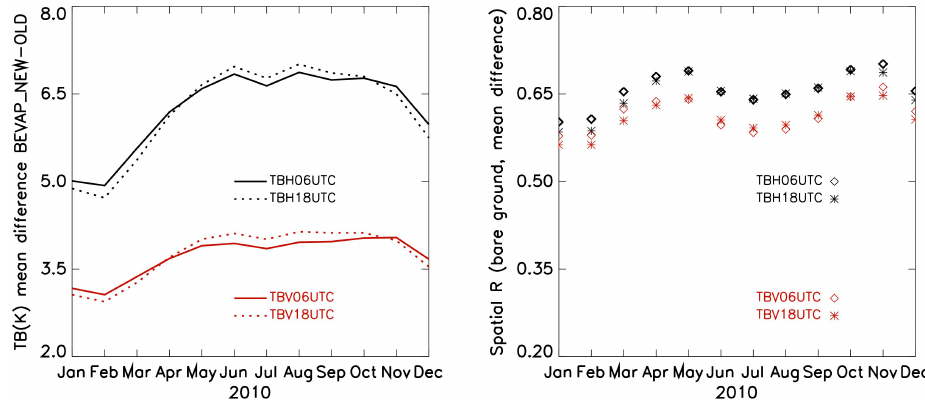
Fig. 7. (left) Brightness temperature global monthly mean sensitivity to the new bare soil parameterization for 2010 (solid and dashed lines), (right) spatial correlation between the fraction of bare ground and the brightness temperature global monthly difference (stars and diamonds). Both horizontal and vertical polarizations (40 ◦ incidence angle) are represented for 06:00UTC and 18:00UTC. Table 6. Monthly mean statistics of the difference between SMOS TB observations and simulated TB. Results are given at 06:00UTC, for both BEVAP OLD and BEVAP NEW, at both horizontal and vertical polarizations, based on 40 ◦ incidence angle observed and simulated